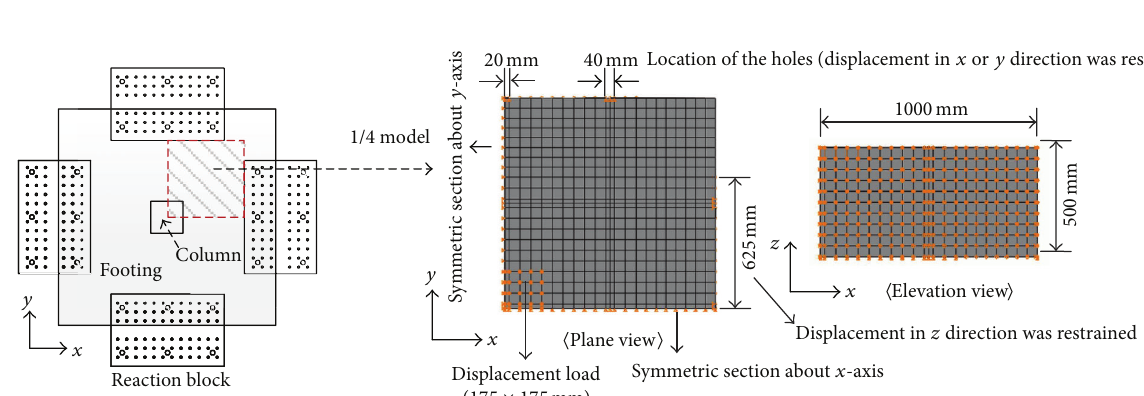
Figure 11: Loading and boundary condition of the finite element model.